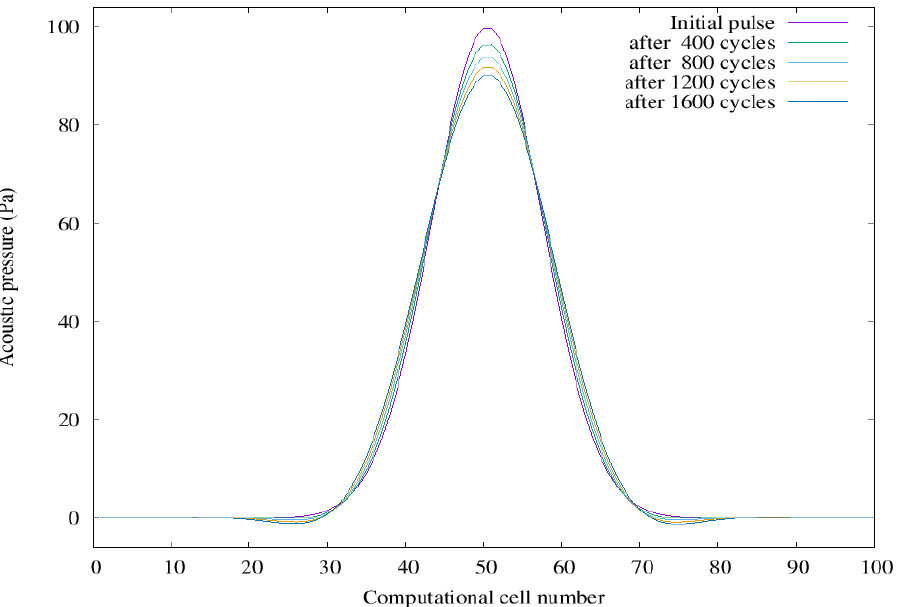
Figure 2. Accuracy test of acoustic waves time-dependent algorithm.